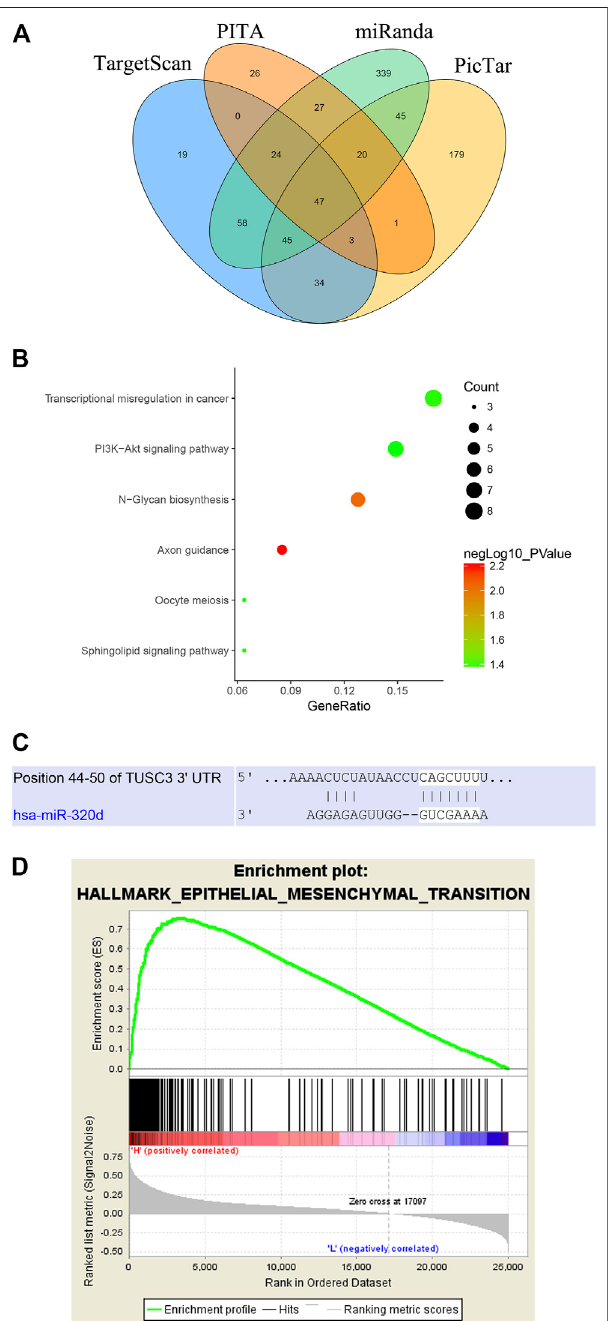
FIGURE2 | The bioinformatics of miR-320d in EGFR-positive colorectal cancer. (A) Venn diagrams of putative miR-320d targets predicted by TargetScan, miRanda, PicTar, and PITA. (B) The KEGG pathways that are enriched for the miR-320d targets. (C) The 3 ′ -UTR of TUSC3 mRNA harbors one miR-320d cognate sites. (D) Performance of GSEA based on TCGA datasets.; Abbreviations: KEGG, Kyoto Encyclopedia of Genes and Genomes; GSEA, Gene Set Enrichment Analysis; TCGA, The Cancer Genome Atlas.